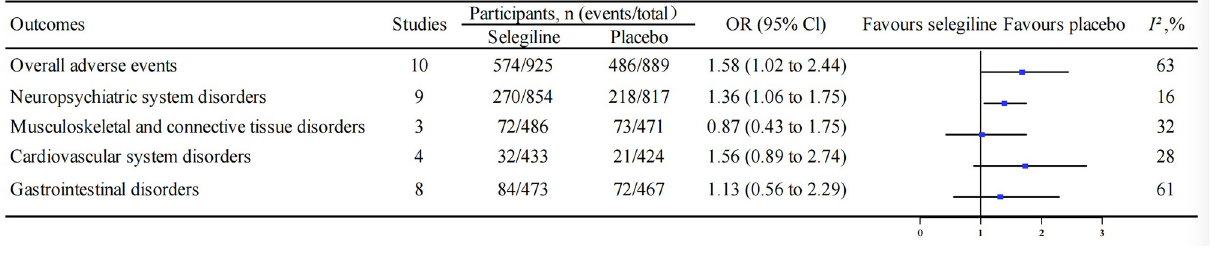
FIGURE4 Comparison of the incidence for overall adverse events and those stratified by disorders between selegiline and placebo. OR, odds ratio; 95% CI, 95% confidence interval.